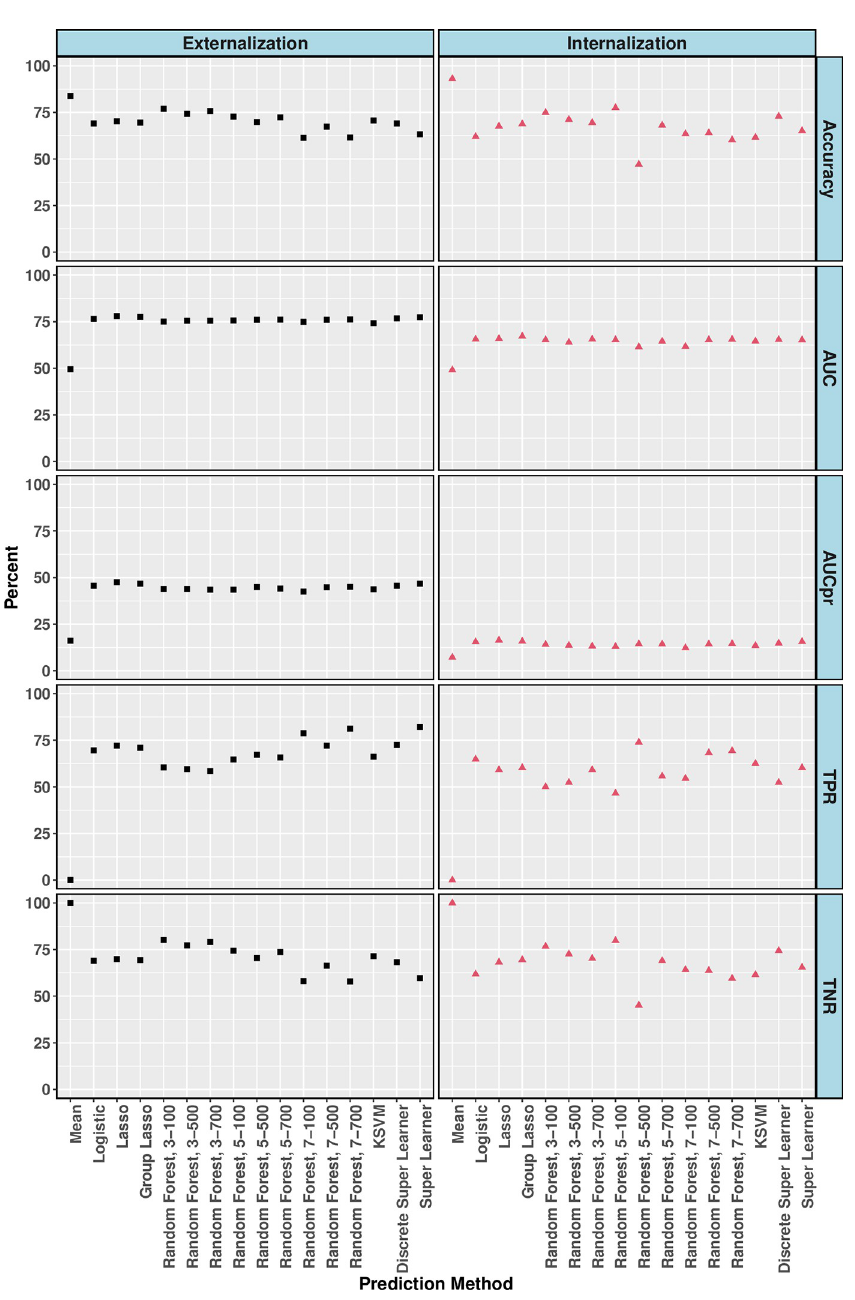
Fig 3. Crossvalidated performance metrics at optimal threshold for predicting externalizing problem behavior (externalization; left panel) and internalizing problem behavior (internalization; right panel); using predictions from Superlearner ensemble as well as individual candidate algorithms. Individual candidate algorithms included mean learner (Mean), logistic regression (Logistic), lasso regression (Lasso), group lasso regression (Group Lasso,) random forest with different combinations of number of variables sampled at each split and number of trees, and support vector machine with radial basis kernel function (KSVM). ACU = area under the curve, AUCpr = area under the precision recall curve, TPR = true positive rate, TNR = true negative